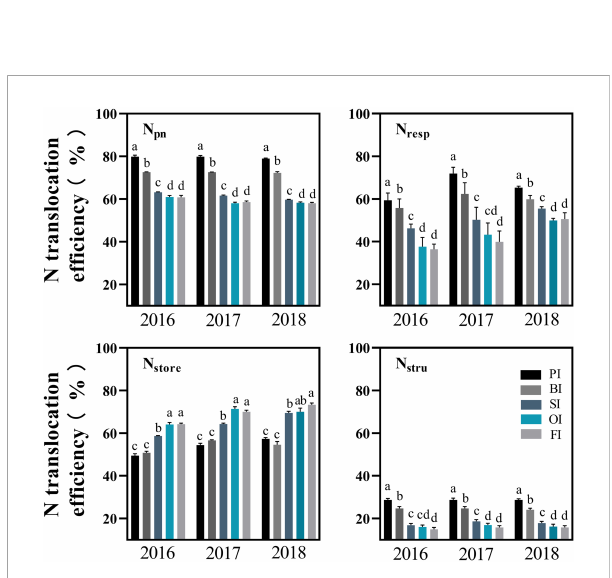
FIGURE 6 Translocation ef fi ciency of different leaf N components. PI and BI represent drip irrigation under plastic fi lm mulch and biodegradable fi lm mulch, respectively; SI, drip irrigation incorporating straw returning; OI, drip irrigation with the tape buried to a shallow soil depth; FI, furrow irrigation. N pn , photosynthetic protein N. N resp , respiration protein N. N stru , structural protein N. N store , storage N. The error bars represent standard deviations. Different lowercase letters indicate signi fi cant differences at P <